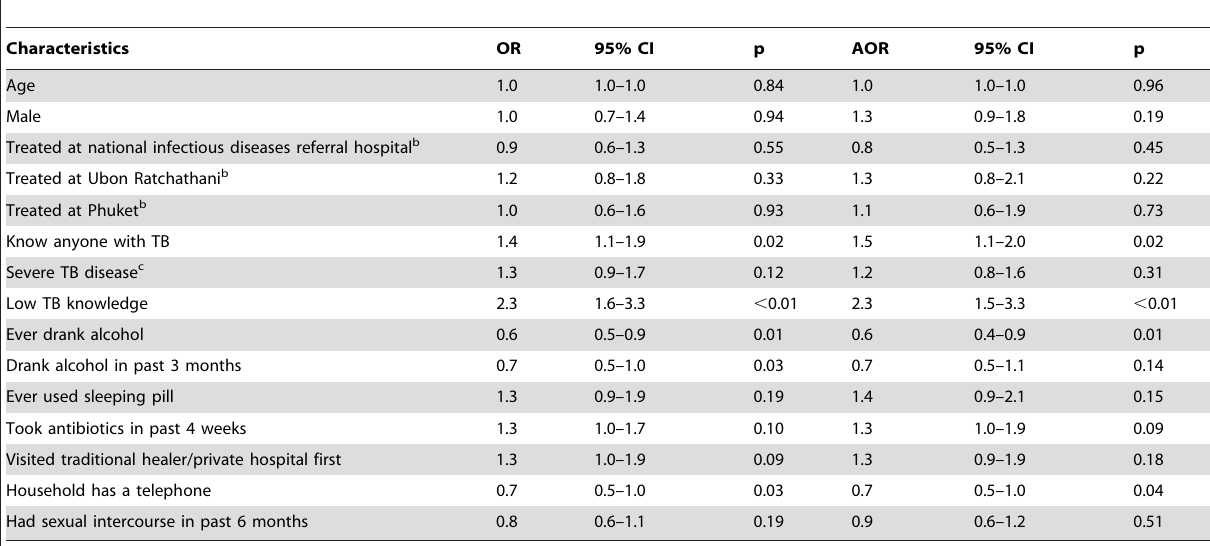
Table 5. Bivariable and multiple logistic regression analyses of predictors for having low HIV knowledge a among HIV-infected TB